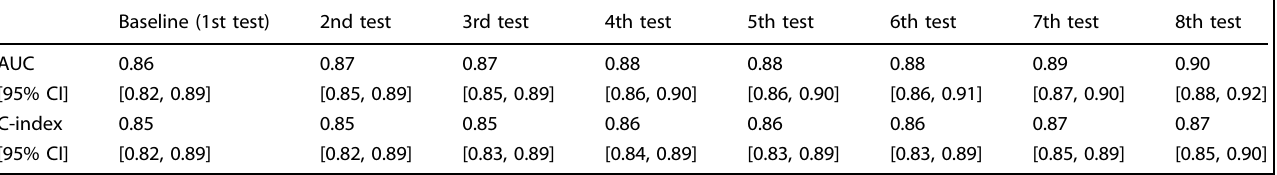
Table 5. Prediction strength of cumulative laboratory tests without using cut-off